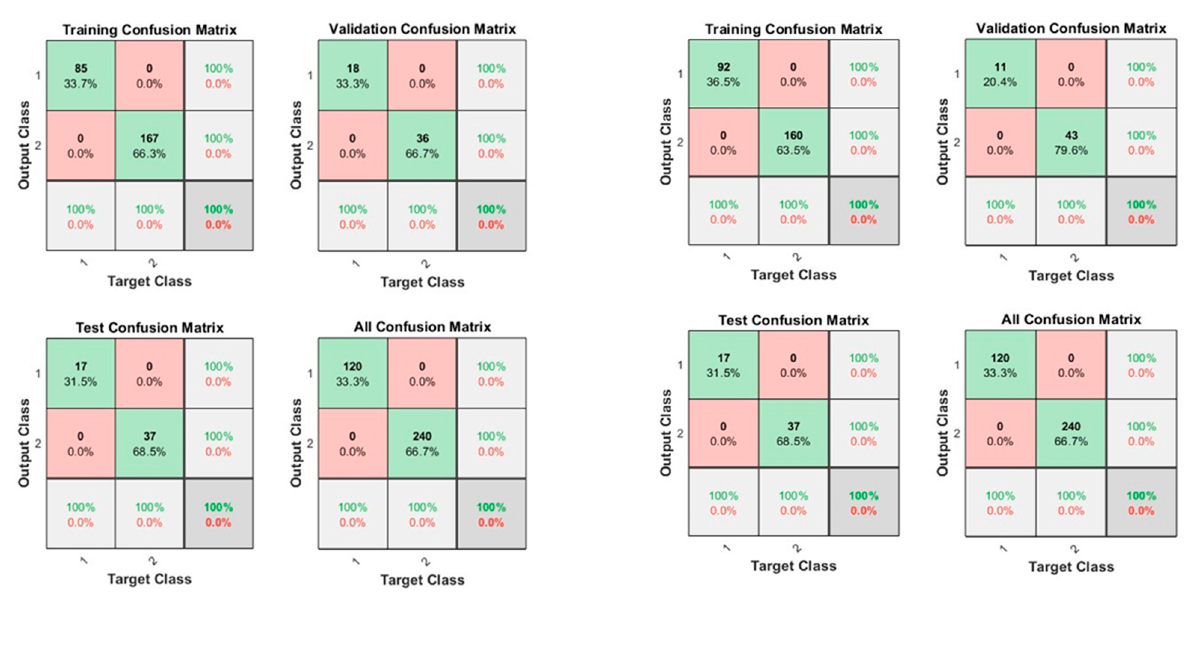
Figure 13. Confusion matrices of the Dataset-4, where class label 1 shows the Normal operating conditions and class label 2 shows the Leak operating conditions of the pipeline using ( a ) 10 Neurons and ( b ) 50 Neurons.